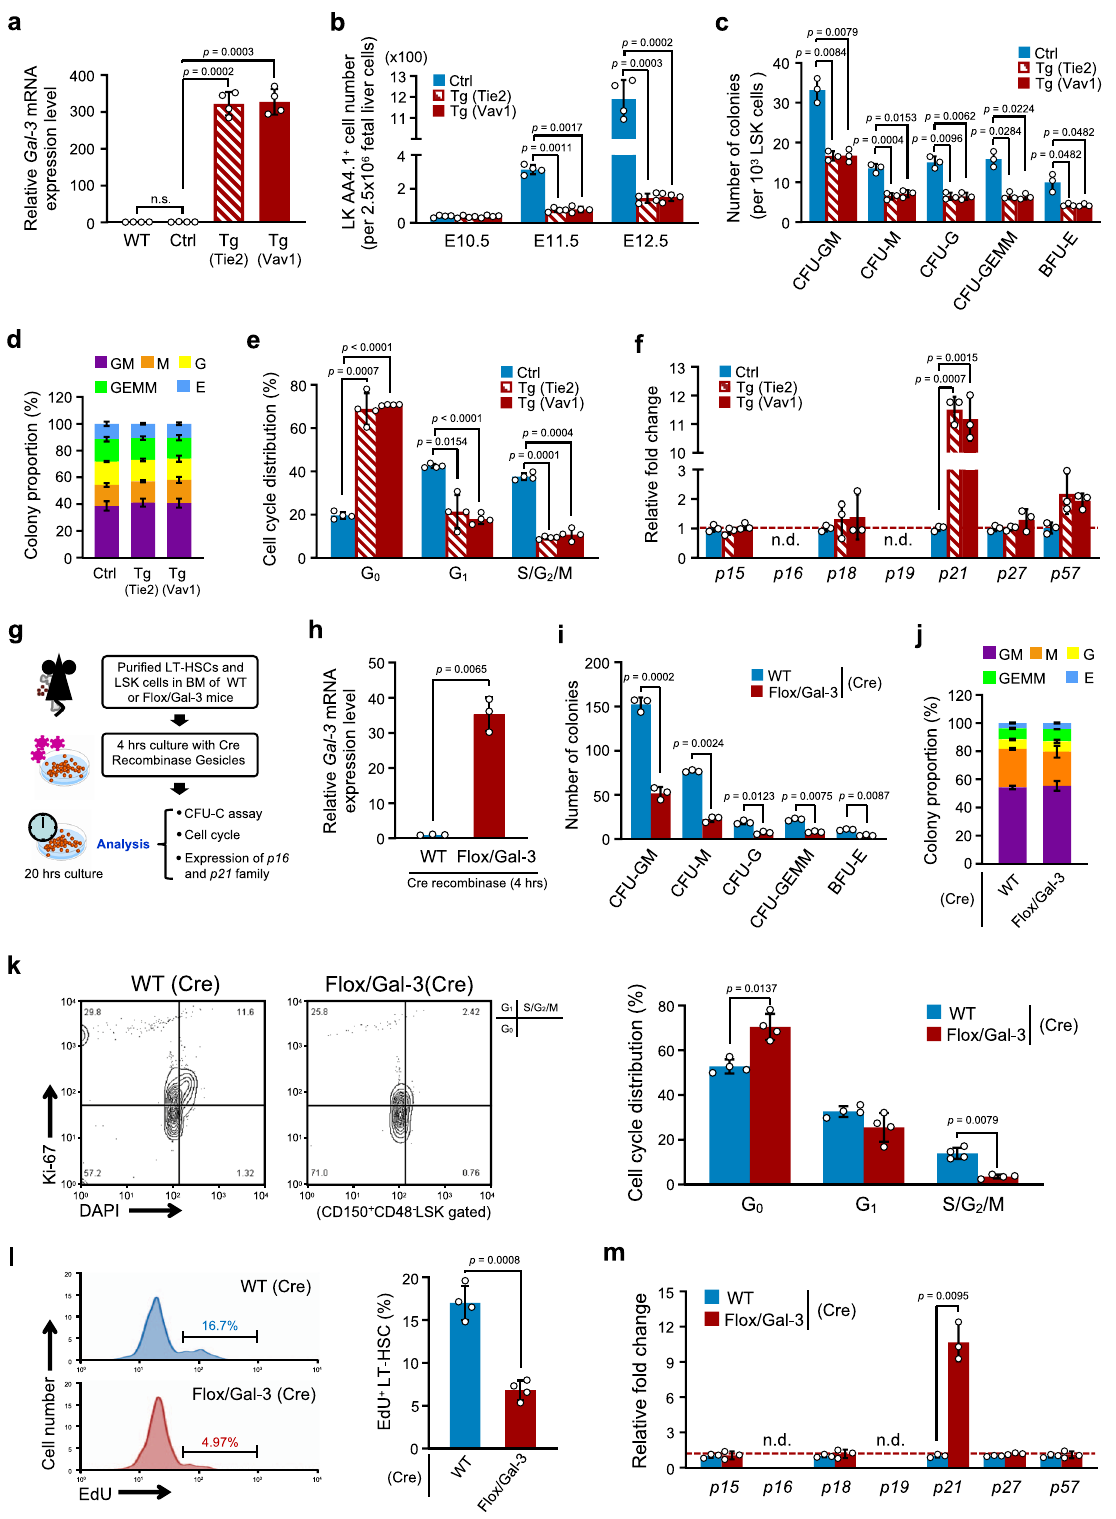
pathways affects the expression of Gal-3 in LT-HSCs. Sorted LT- HSCs from BM were pre-treated short-term with speci fi c inhi- bitors of PI3K or MEK, and then stimulated with Ang-1 or Thpo (Fig. 5d). We found that the PI3K inhibitor LY294002 but not the MEK inhibitor PD98059 blocked Ang-1- or Thpo-induced